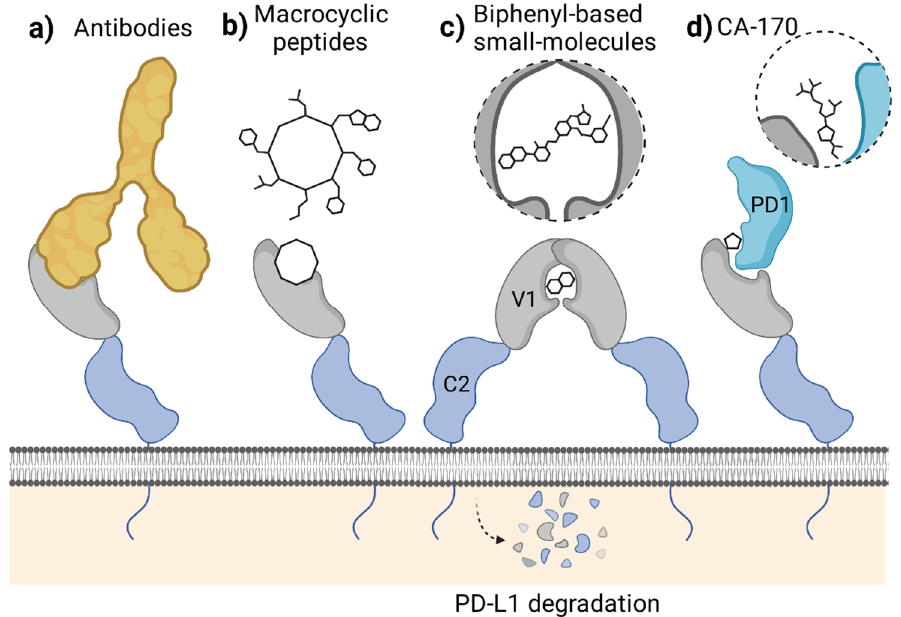
Figure 4. Mechanisms of PD-1/PD-L1 blockade attributed to different classes of molecules targeting the extracellular domain of PD-L1. (a,b) The blockade of PD-L1 surface with antibodies (a) or macrocyclic peptides (b) which antagonize PD-1 binding. (c) Small-molecule-induced PD-L1 dimerization leading to cell surface PD-L1 loss by the protein maturation blockade or internalization. (d) Forming a defective ternary complex between CA-170, PD-1, and PD-L1. Figure created with BioRender.